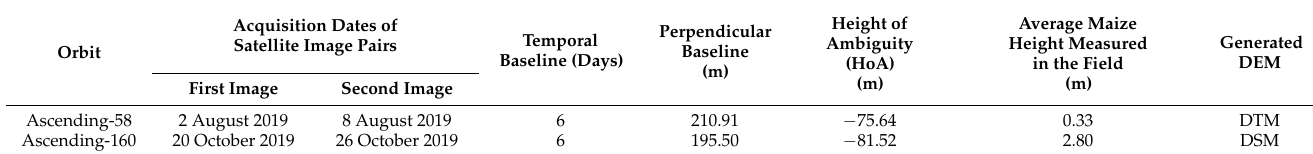
Table 5. Sentinel-1 satellite image pairs used for calculating plant